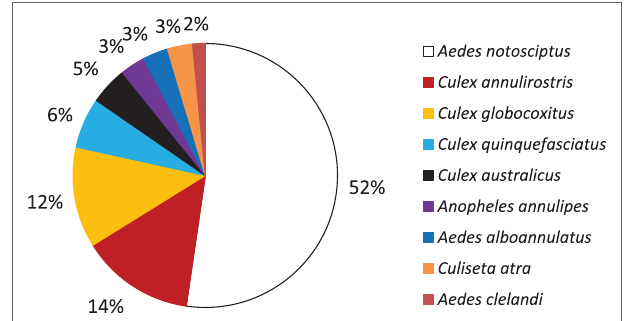
FigUre 4 | Percentage of containers found breeding each species of mosquito collected across the study area.